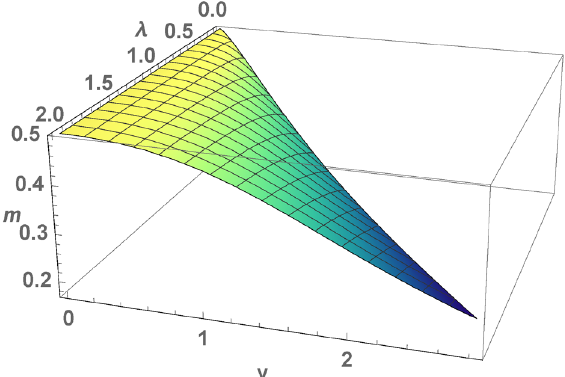
1 n ( n k , ) as a function of (cid:31) , v , k , 2 N k = ↑ − ↓ (cid:31)